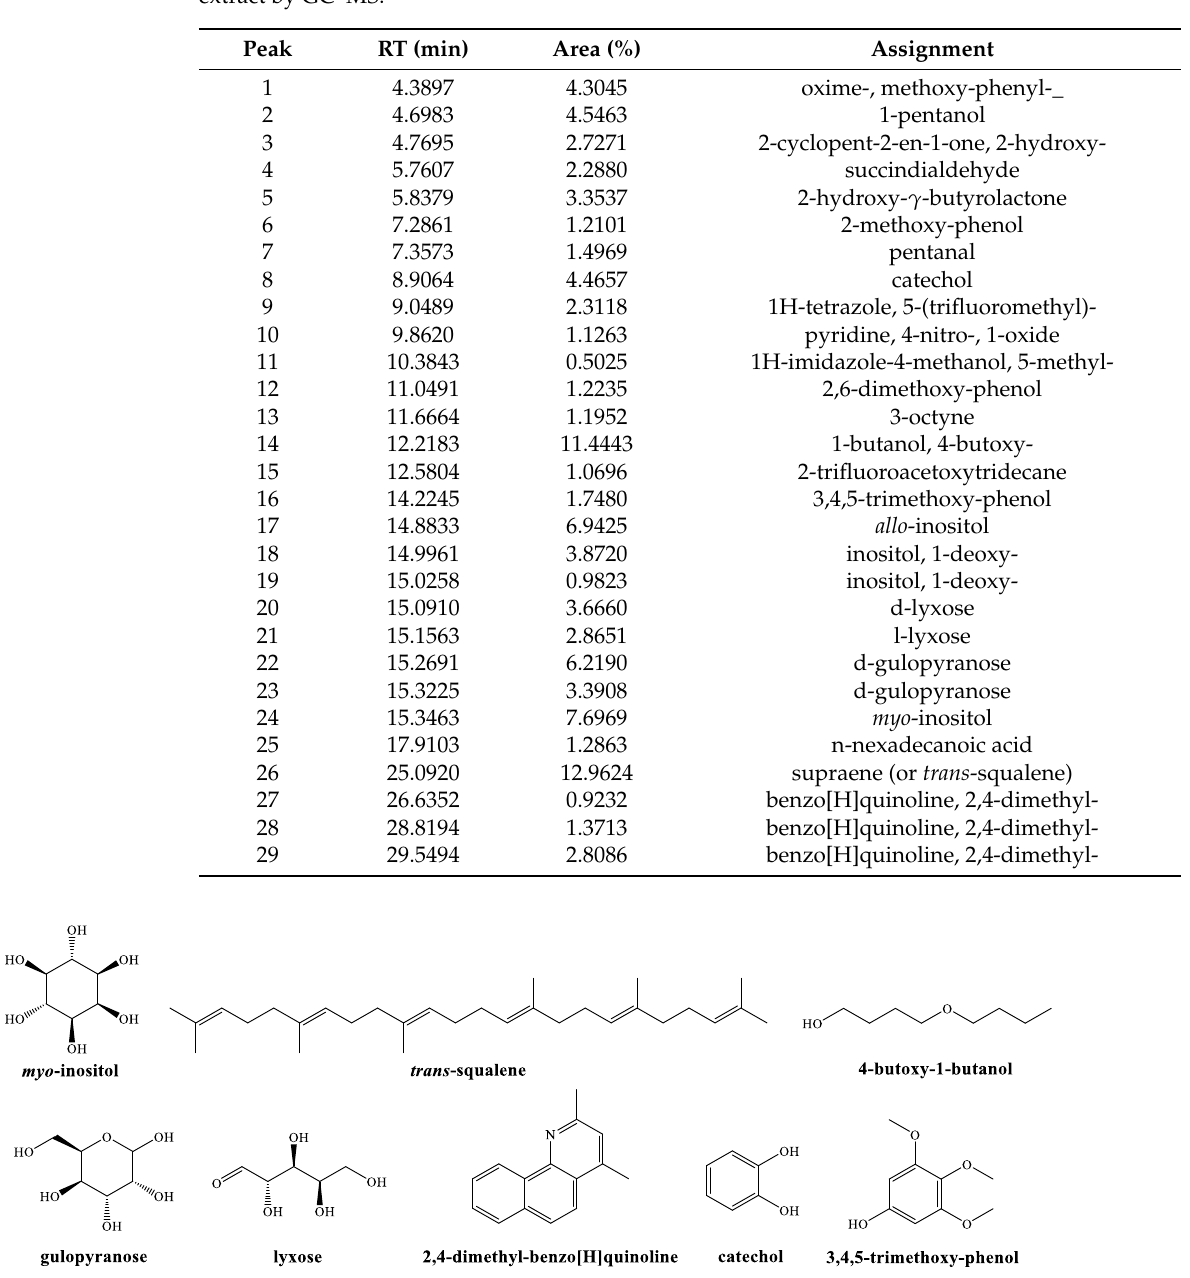
Table 1. Most representative phytochemicals identified in Q. ilex subsp . ballota bark aqueous ammonia extract by GC–MS.